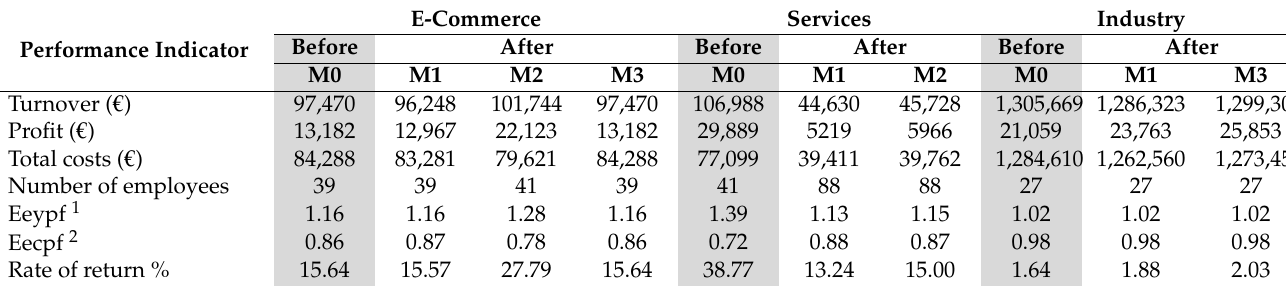
Table 4. The companies’ KPIs before and after Spc